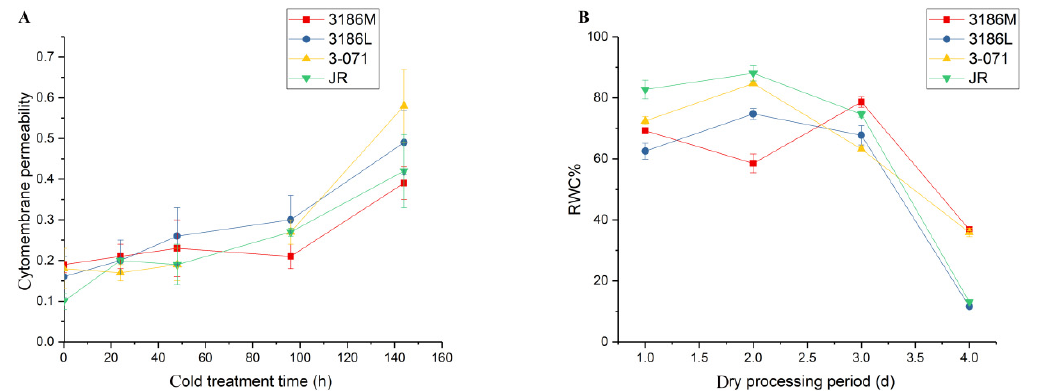
Figure 6. ( A ) Determination of the relative permeability of the plasma membrane by measuring the conductivity of several test tomato materials at di ff erent time points after the low temperature treatment. ( B ) During drought treatment, the relative water content (RWC) was measured at di ff erent times. The data represent the means of three replicates ± SD. All experiments were repeated three times with similar results.